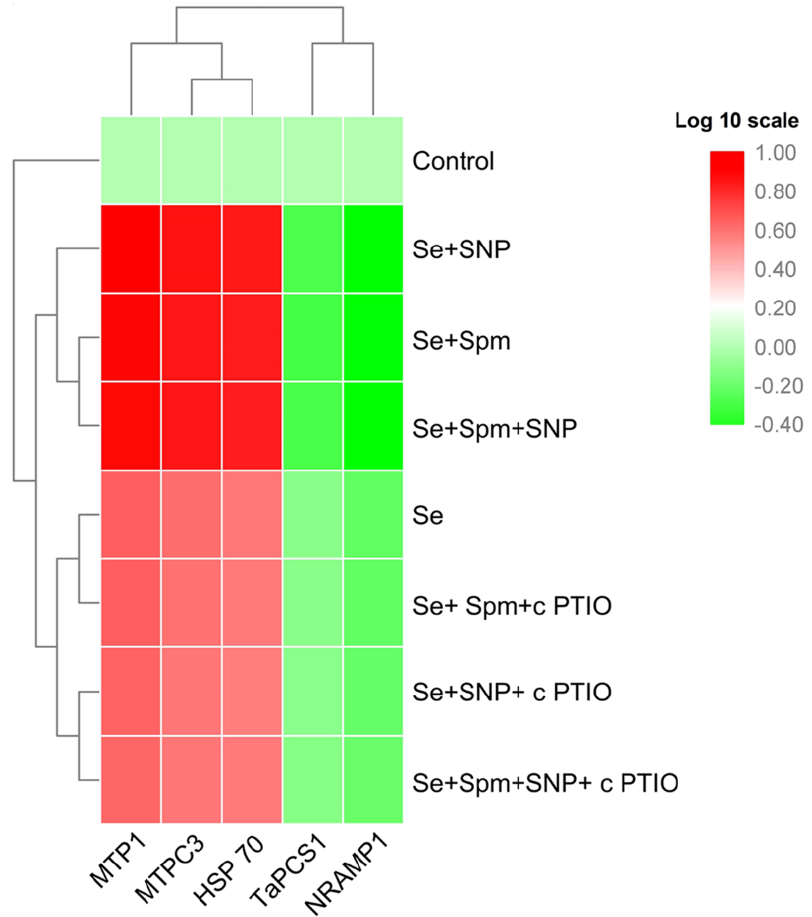
Figure 8. Heat map representing the relative transcript abundance of differentially expressed heavy metal-related genes in leaves of 49-day-old wheat plants grown under control and Se stress (1 mM) sprayed with 1.0 mM Spm or 0.1 mM SNP alone or together, combined with 0.1 mM cPTIO, a NO scavenger, and hierarchical cluster analysis results. The gene expression intensity is represented by colours from green (low) to red (high).